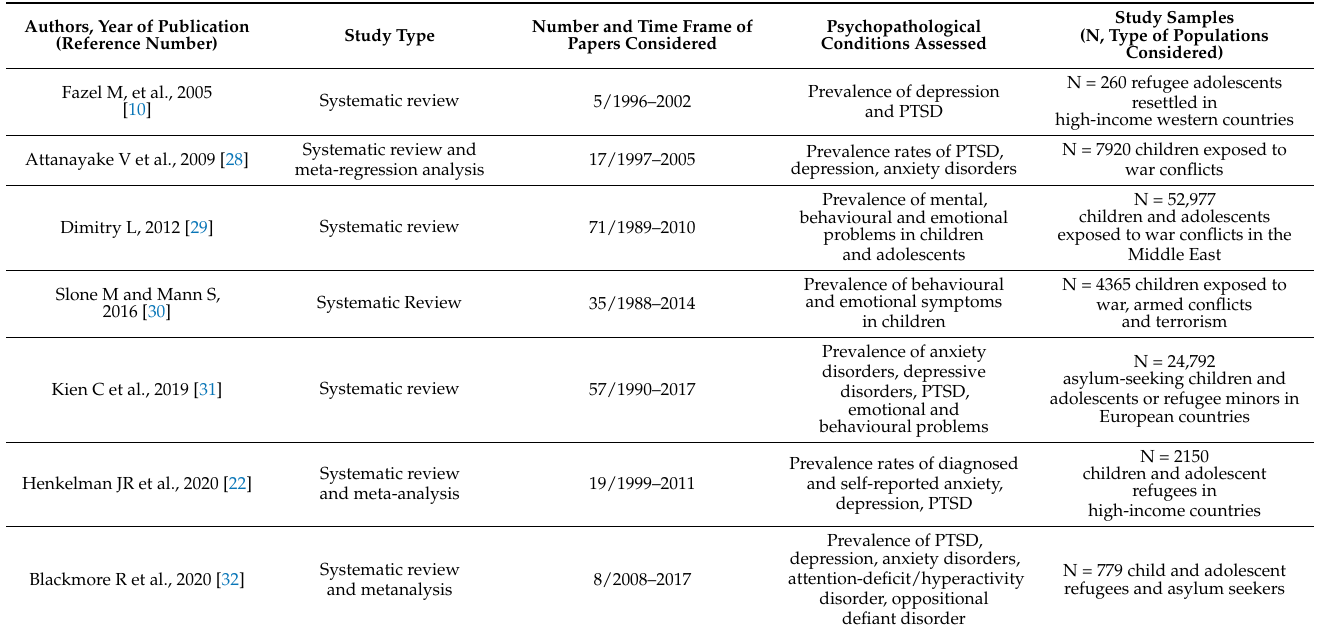
Table 4. Systematic reviews and/or meta-analyses relating to the mental health consequences of conflicts on children/adolescents.